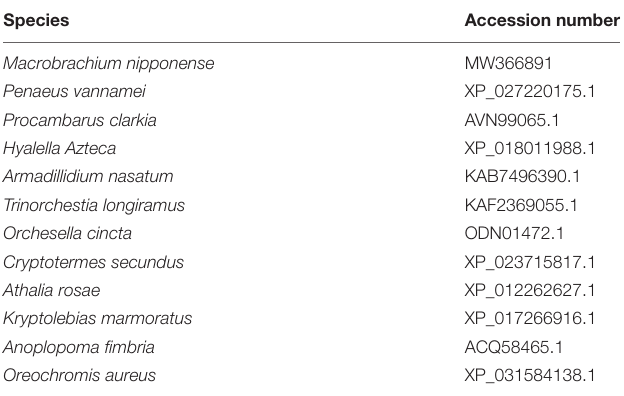
TABLE 2 | Species used for phylogenetic tree